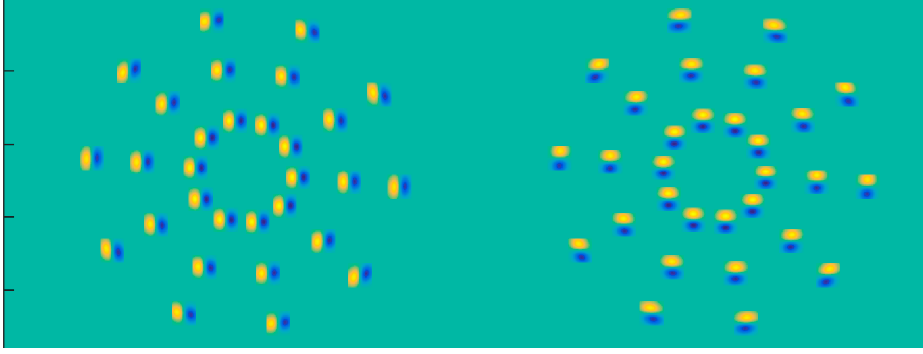
Figure 7. The kernels of the first partial derivatives g x , g y of Equation (11) at different positions on the fisheye image.